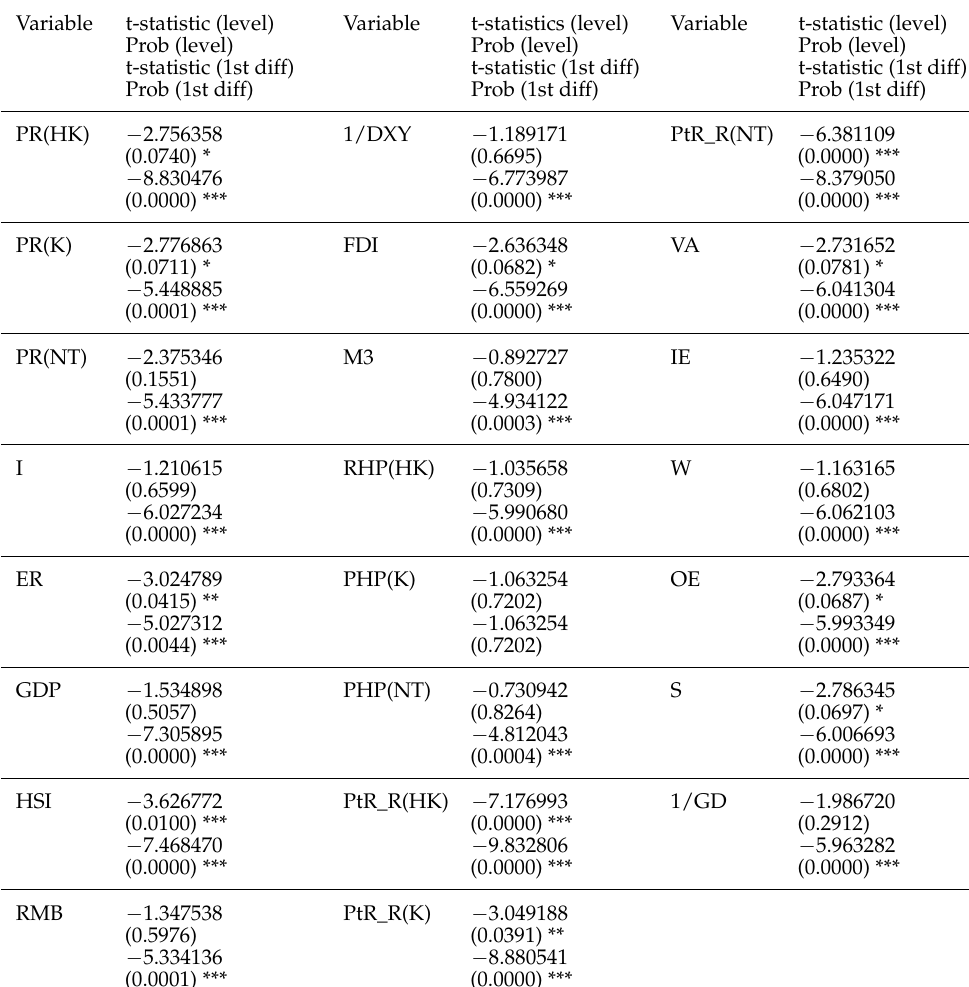
Table A1. Full results of ADF